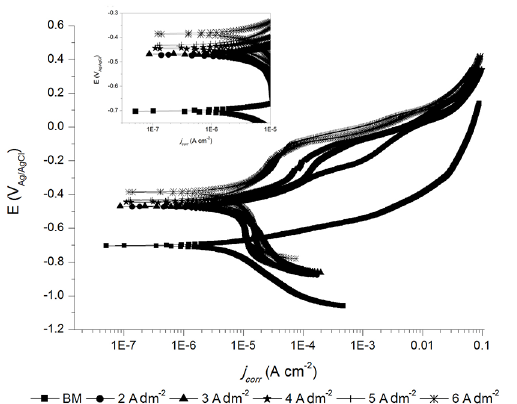
Figure 5. Potentiodynamic polarization curves of Co-Ni/SiC coatings and base metal in a 3.5 wt.% NaCl solution. The increase in the coating condition (cathodic current density) shifted the corrosion potential back to the potential of base metal. The corrosion potential of the Co-Ni/SiC coatings shifted to more positive potential values (-0,47505 V to -0,38485 V ) than that of the base metal Ag/AgCl Ag/AgCl (-0,70258 V ). This shift in corrosion potential Ag/AgCl